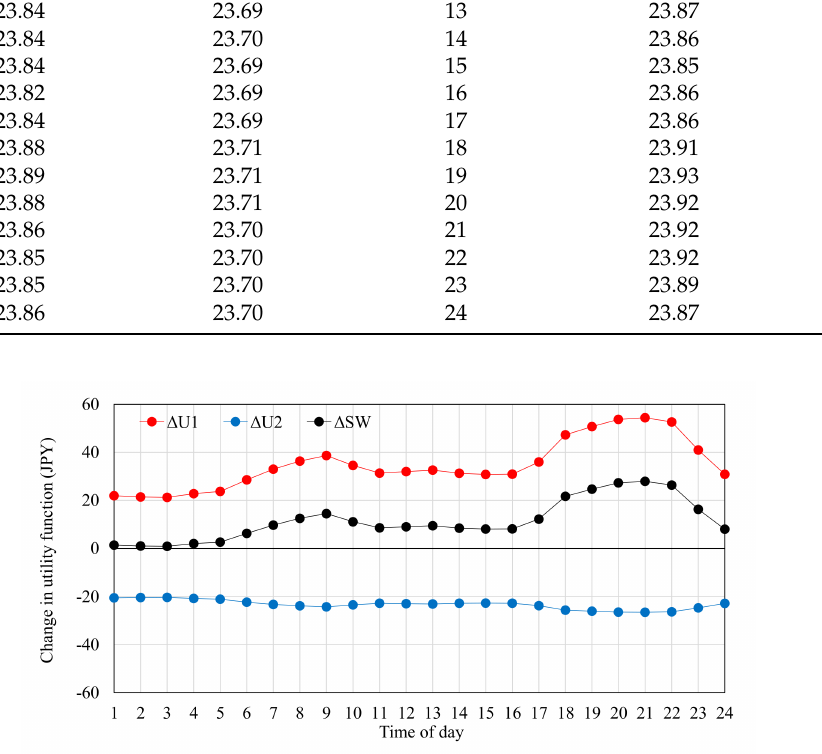
Figure 7. Changes in each function by the 1% DR request in the day of the highest electricity